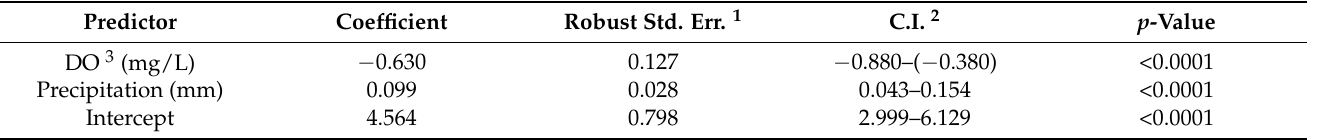
Table 7. Mixed-effects negative binomial regression model for environmental and water quality factors associated with the concentration of E. coli in coastal water samples (n = 363) from oyster production regions in